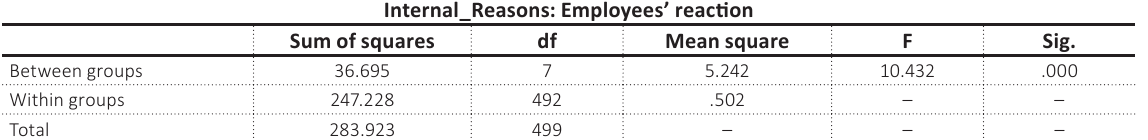
Table 12. ANOVA results